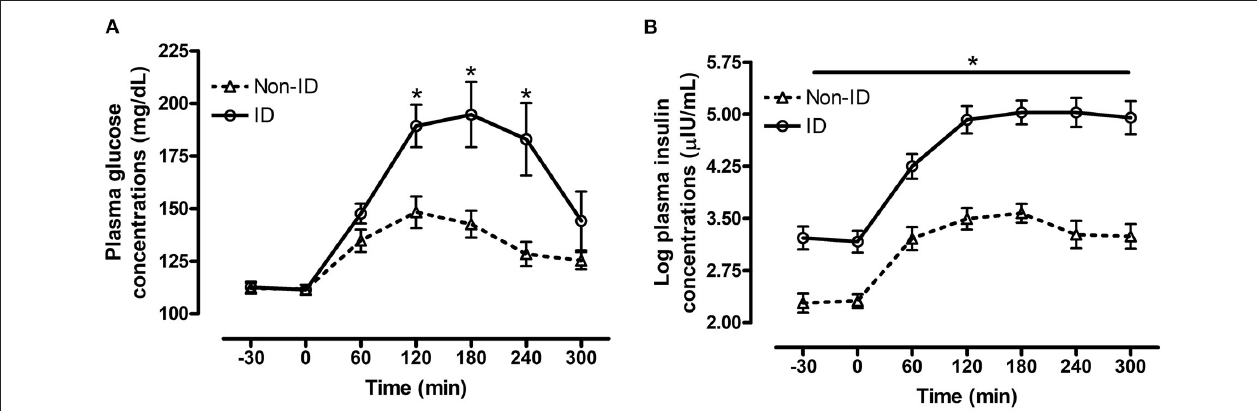
FIGURE 1 | Effect of insulin status on postprandial glucose and insulin responses to feeding a meal of whole oats. Postprandial plasma glucose and log insulin concentrations following consumption of a meal of whole oats providing 1g starch/kg BW in non-ID and ID horses. (A) Effect of insulin status (INS* time interaction P = 0.02) on glucose concentrations (mg/dL) at baseline − 30, 0min and 60, 120, 180, 240, and 300min post feeding. (B) Effect of insulin status (INS* time interaction P = 0.04) on log insulin concentrations ( µ IU/mL) at baseline ( − 30, 0min) and 60, 120, 180, 240, and 300min post feeding. Dotted line with triangles: measurements in non-ID horses ( n = 12); Solid line with circles: measurements in ID horses ( n = 11). Data of horses that did not consume their meal within 60min were removed from the final analysis. Data are presented as least square means ± standard error of the mean. *Indicates differences ( P ≤ 0.05) between non-ID and ID horses for plasma metabolite concentrations at specific timepoints. ID, insulin dysregulated horses; INS, effect of insulin